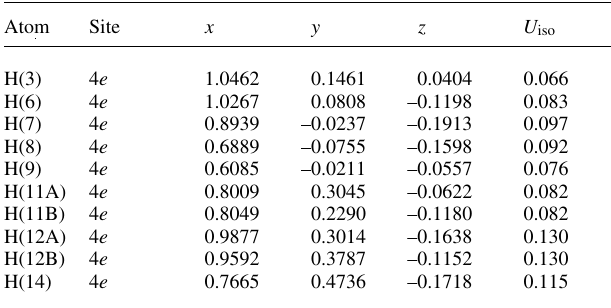
Table 2. Atomic coordinates and displacement parameters (in Å 2 )